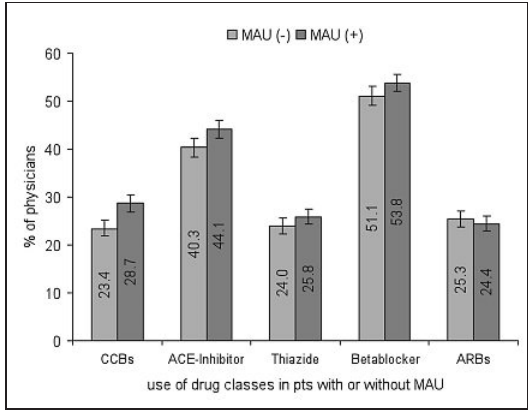
Use of antihypertensive drug classes in patients with (+) or without (–) microalbuminuria. Mean prevalence estimates [95% CI] are provided. ARBs – Angiotensin receptor blockers; ACE – Angiotensin Converting Enzyme; CCBs – Calcium Channel Blockers.